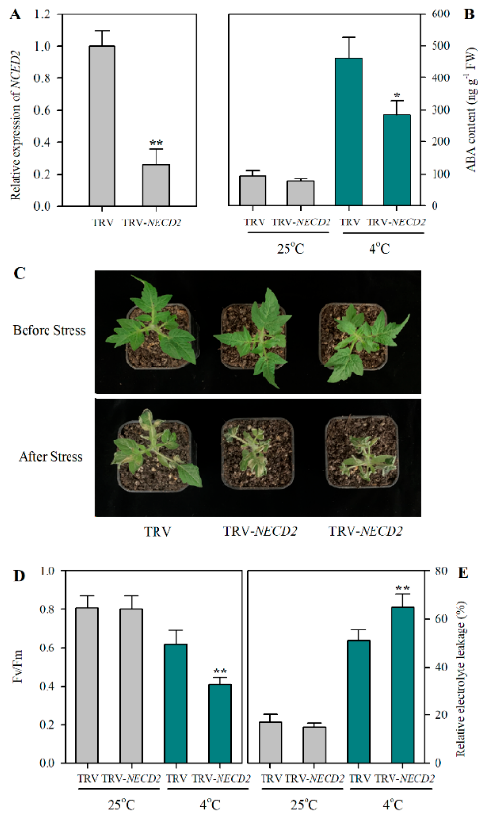
Figure 3. Effects of NCED2 suppression on cold tolerance in tomato. ( A ) Relative expression of NCED2 in TRV and TRV- NCED2 plants under cold conditions. ( B ) ABA contents in TRV and TRV- NCED2 plants under cold conditions. ( C ) Phenotypes of TRV and TRV- NCED2 tomato plants subjected to cold stress. ( D ) Fv/Fm in TRV and TRV- NCED2 plants under cold conditions. ( E ) Relative electrolyte leakage in TRV and TRV- NCED2 plants under cold conditions. TRV and TRV- NCED2 tomato plants were exposed to cold stress and leaves were collected for the expression analysis of NCED2 and cold tolerance assays. Data presented are means of three biological replicates ( ± SD). Asterisks indicate significant differences (** p < 0.01, * p < 0.05) according to Student’s t -test.